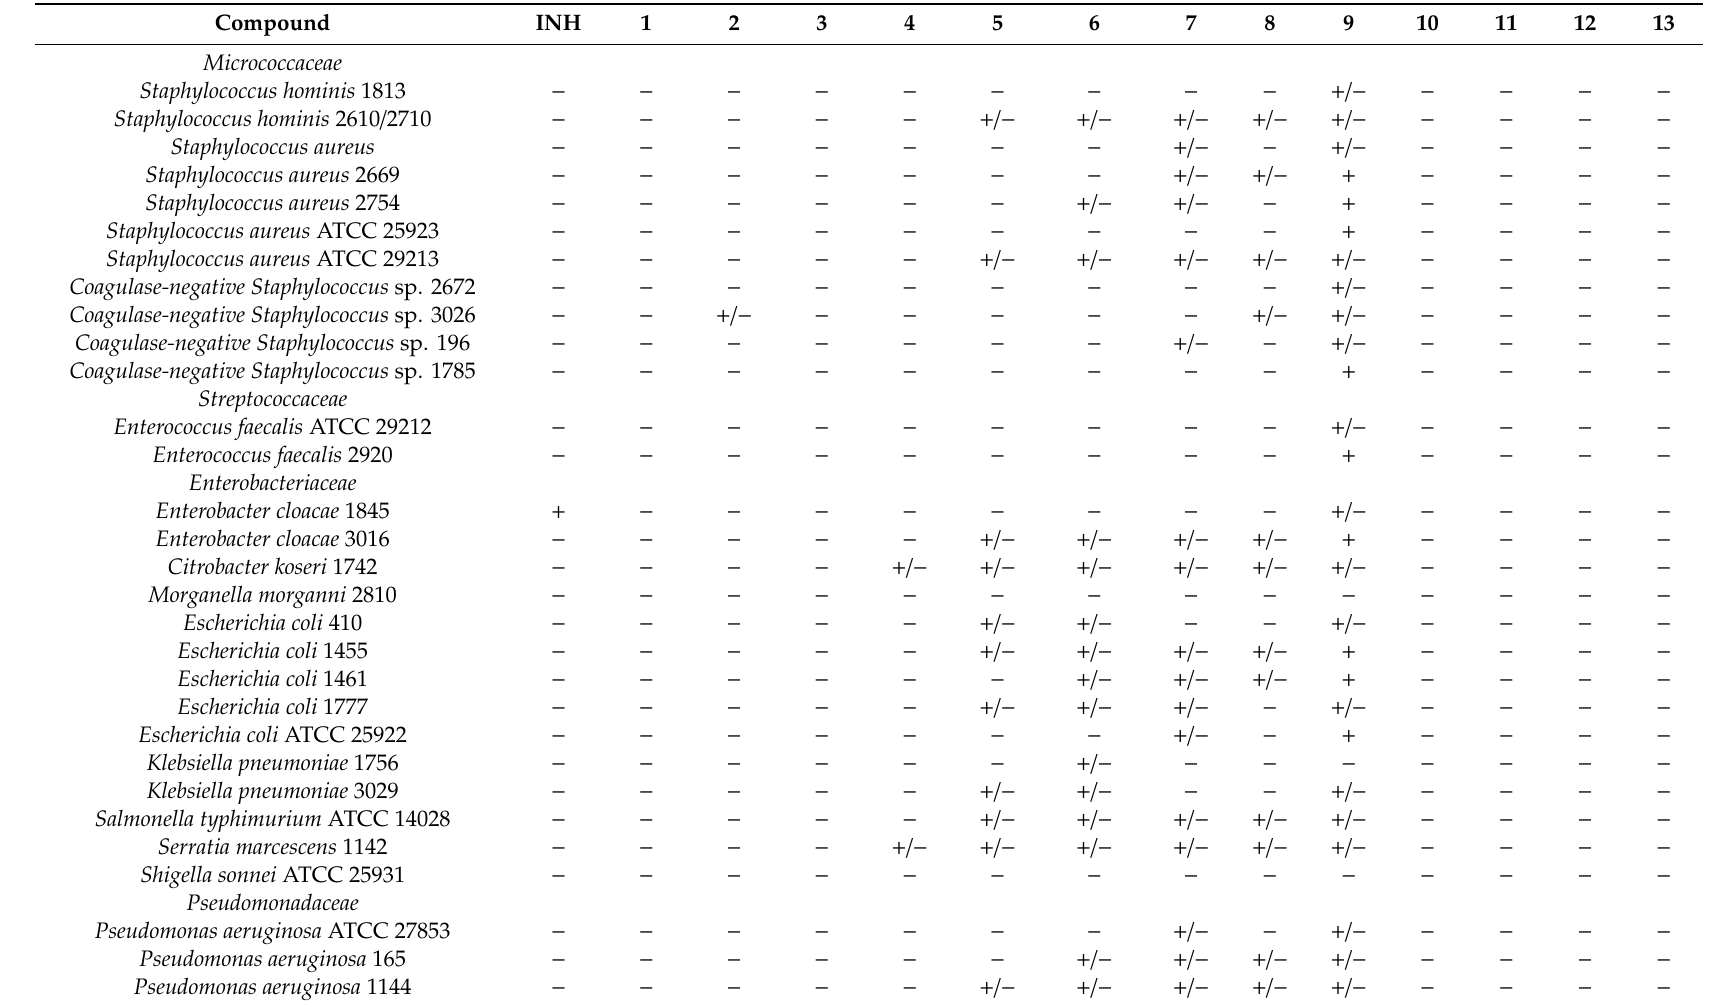
Table 3. The antimicrobial evaluation of the new synthesized compounds. Compound